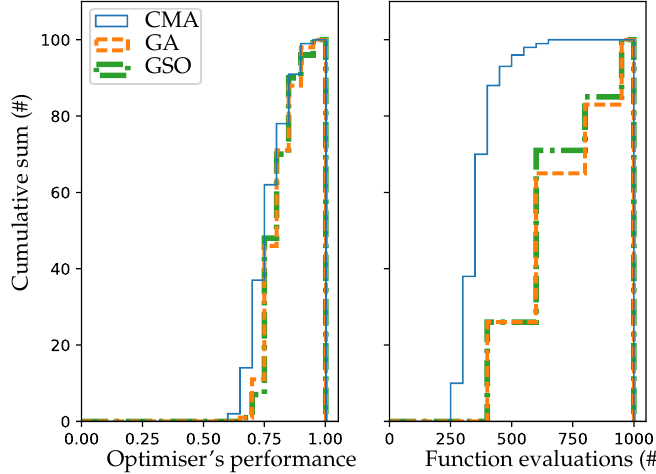
Figure 4. Optimisers’ performance and required number of function evaluations prior to termination. The results are shown for the 100 runs performed by each